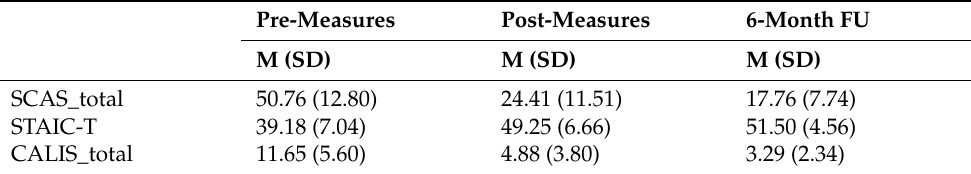
Table 3. Descriptive statistics for pre–post and 6-month FU for CBT groups for